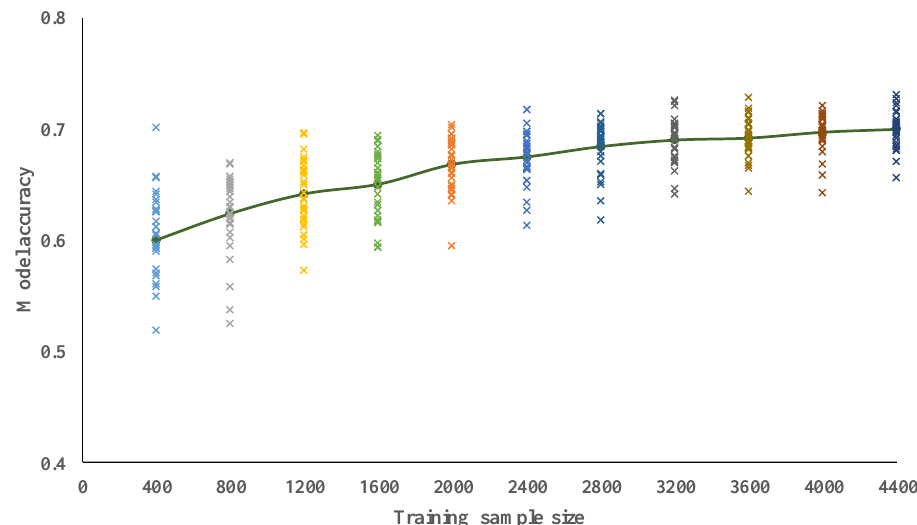
characteristics.